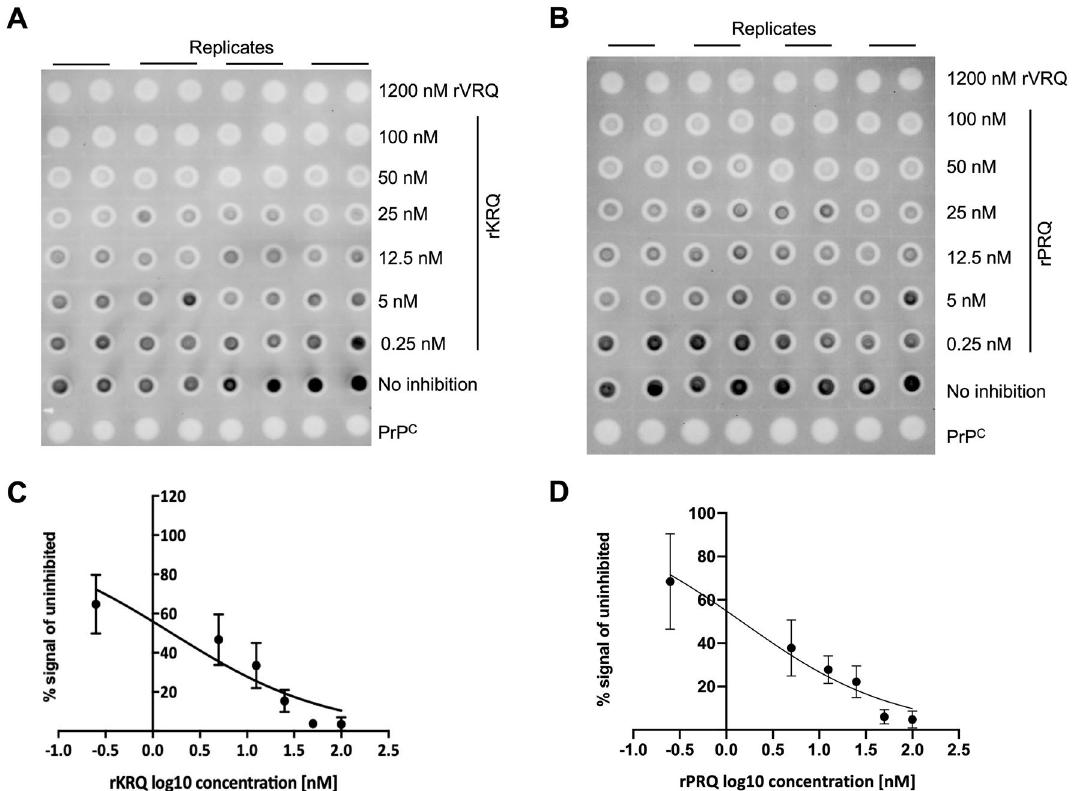
Figure 2. IC50 value determination for rPrP variants at position 136 inhibiting ovine scrapie replication. IC50 values were determined in the PMCA model of prion replication by measuring the level of inhibition for rPrP over 6 concentrations (as indicated for each rPrP). PMCA reactions were carried out in 4 replicates and each sample analysed in duplicate on dot blots ( A , B ). Dot blots were analysed by densitometry and the PrP Sc signal above background (1200 nM rVRQ inhibition) were averaged for the duplicate analyses. The mean of replicate PMCA reactions with SD were plotted to calculate IC50 values ( C , D ). Representative examples are shown for rKRQ ( A , C ) and rPRQ ( B , D